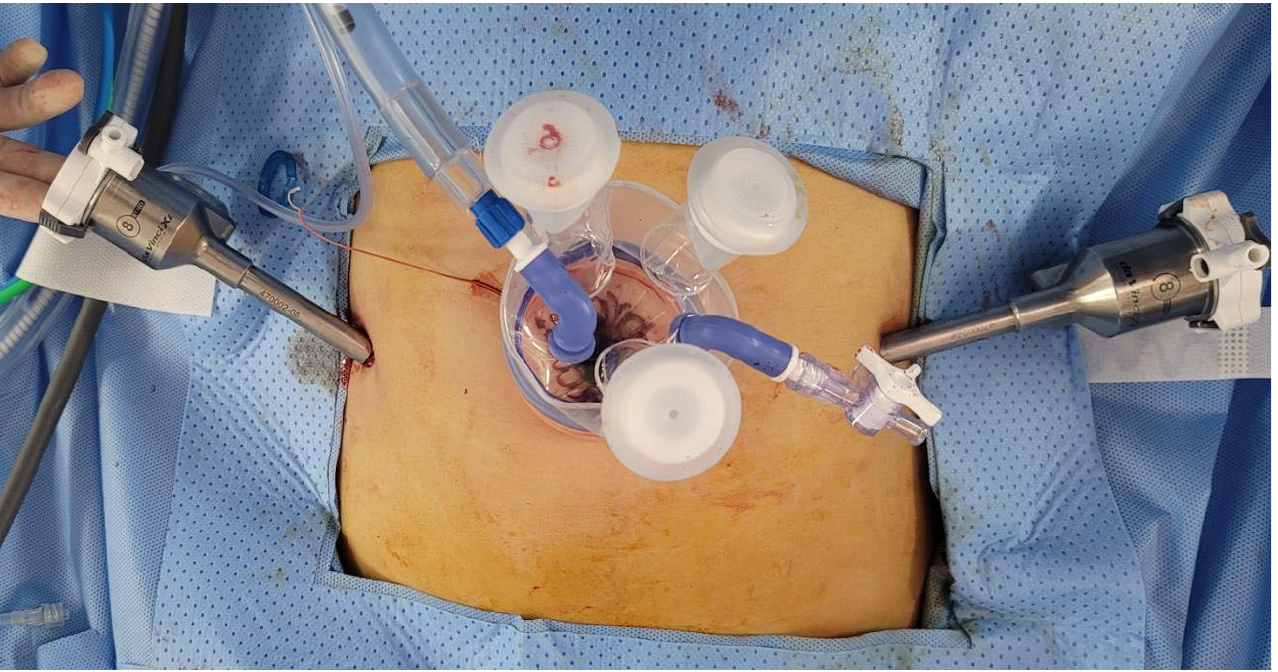
Figure 2. Actual trocar placement for robotic single ‐ site plus two ‐ port myomectomy (RSTM).